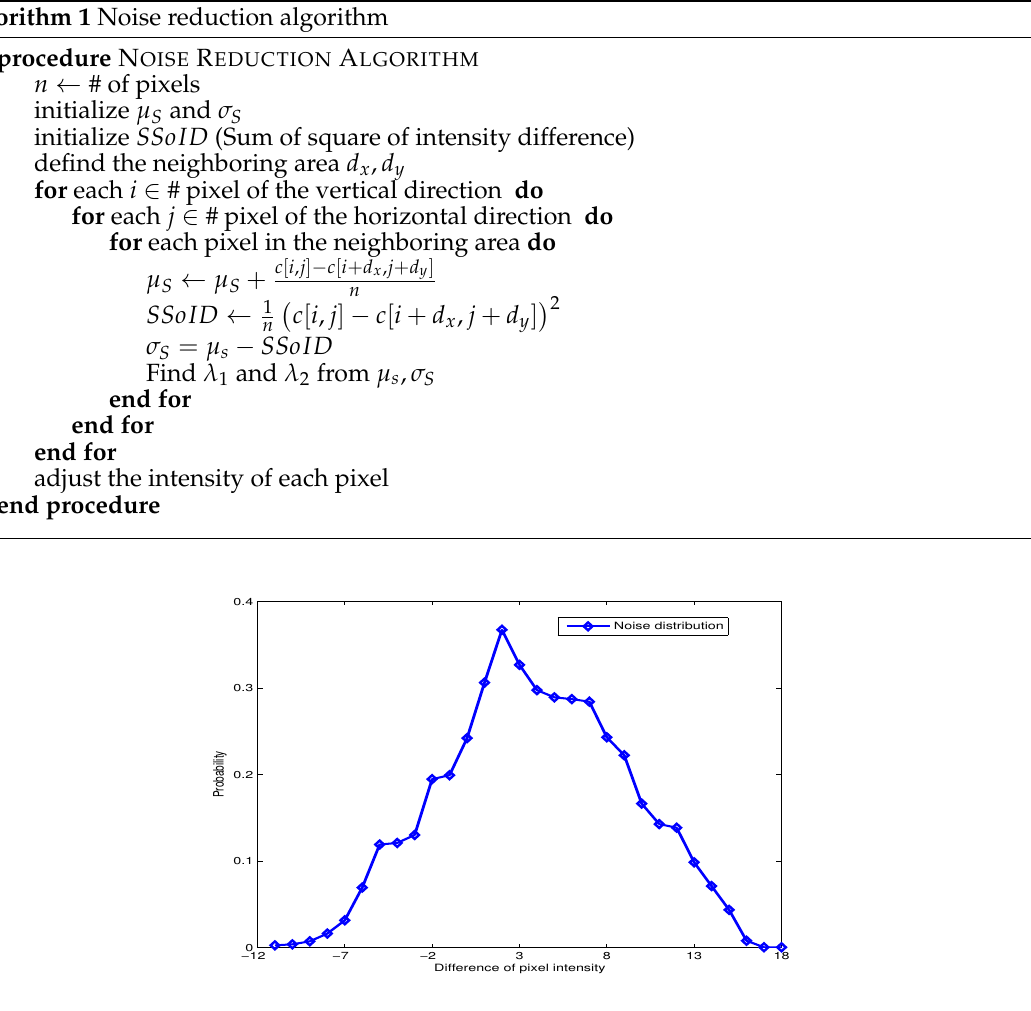
Figure 8. Histogram of